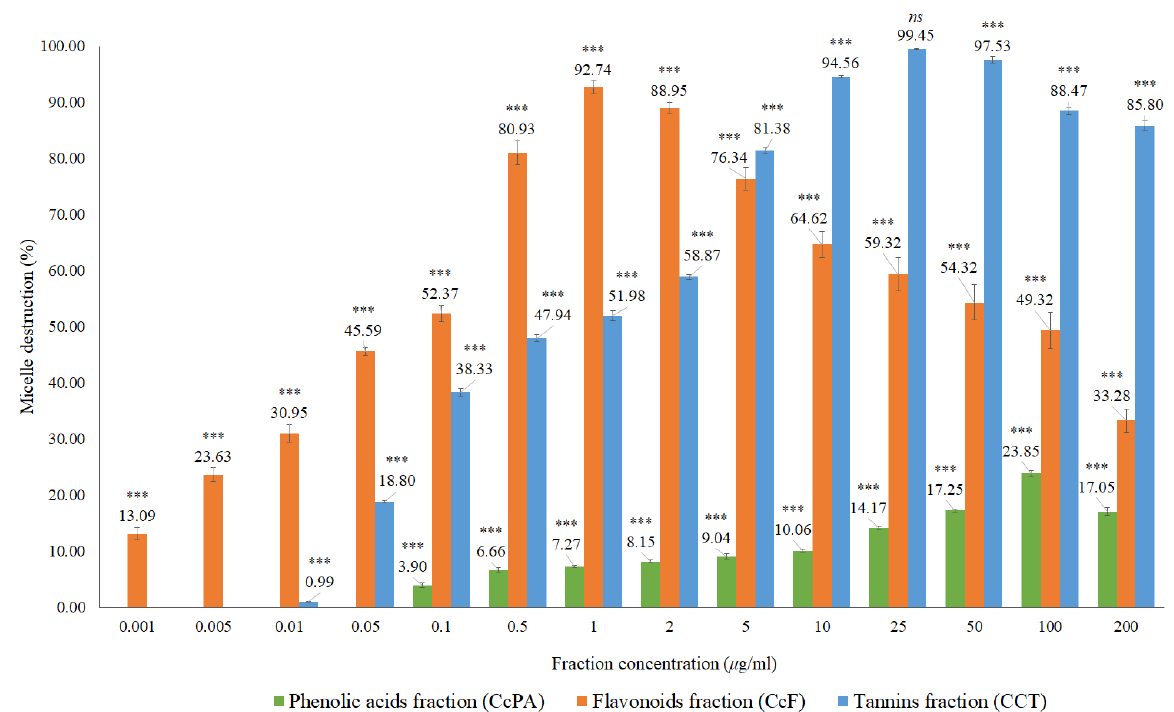
Figure 7. In vitro cholesterol micellar solubility assay of the CcPA, CcF and CcT phenolic fractions of Cymbopogon citratus. The results are expressed as the mean ± standard deviation (minimum of three independent assays, performed in triplicate). The control micelle destruction value was 100%. The statistical tests were performed with *** p < 0.05 compared to the control. ns. no significance. Micellar inhibition was observed for all phenolic fractions, with flavonoids and tan- nins showing the highest percentages of micelle destruction. In the case of the fraction of phenolic acids, 23.85% of maximum micellar destruction was recorded for the concentra- tion of 100 μ g/mL, while for the fraction of flavonoids, the micellar destruction was 92.74% in the concentration of 1 μ g/mL, and for the tannin fraction of 99.45% at a concentration of 25 μ g/mL. Both the fractions of flavonoids and of tannins had a significant effect on micellar destruction of above 90%, which may indicate that the phytochemicals present in these fractions may contribute to the lipid-lowering activity found in the extracts of Cymbopogon citratus . These results corroborate that flavonoids and tannins are the main ones responsible for the hypolipidemic effect of this plant such as that suggested by Mor- gado et al. [17]. To our knowledge, there are no other in vitro studies to support this mech- anism of action (micellar destruction) for this plant, nor for its phenolic compounds.